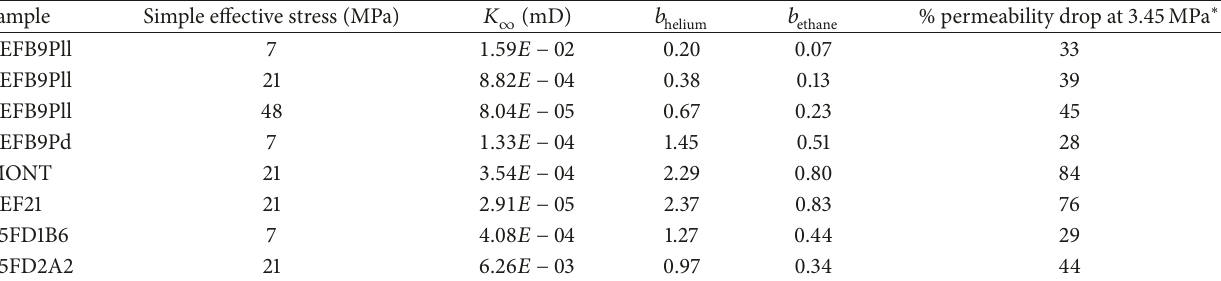
Table 1: Experimental conditions and tabulated data for each sample.